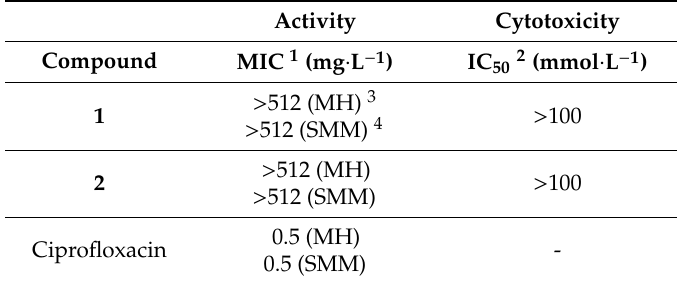
Table 3. Antipseudomonal activities and cytotoxicity of 1 and 2